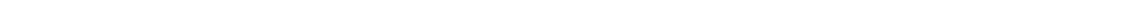
Fig. 5 Pan-cancer analysis of strong vs. weak TAD boundaries (high sequencing depth = 80 million intrachromosomal read pairs). a Schematic of pan- cancer analysis (left panel) and classi fi cation of focally deleted boundaries in cancer according to their strength (right panel). b Schematic of pan-cancer analysis (left panel) and classi fi cation of focally duplicated boundaries in cancer according to their strength (right panel). c Schematic of pan-cancer analysis (left panel) and co-duplications of TAD boundaries with regular enhancers and super-enhancers in cancer (right panel). d Snapshot of the MYC locus: a strong boundary (black bar) is frequently co-duplicated with MYC and potential super-enhancers in cancer patients (highlighted area). IGV tracks from top to bottom: average insulation score across cell types (gray), strong boundaries (black bars), super-enhancer track from SEA (blue bars), RefSeq genes, duplication frequency (red graph) and ICGC patient tandem duplications (red bars). All statistical tests are paired two-sided Wilcoxon rank-sum tests between distributions de fi ned across samples (each sample is a dot in the boxplots). The box in each boxplot represents the fi rst (Q1) and third (Q3) quartiles and the ends of the whiskers are positioned 1.5*(Q3-Q1) away from the ends of the